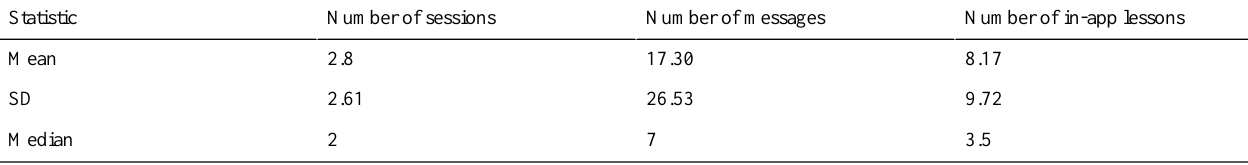
Table 2. Summary statistics for Program usage within the first 6 weeks of the Program (N=258).